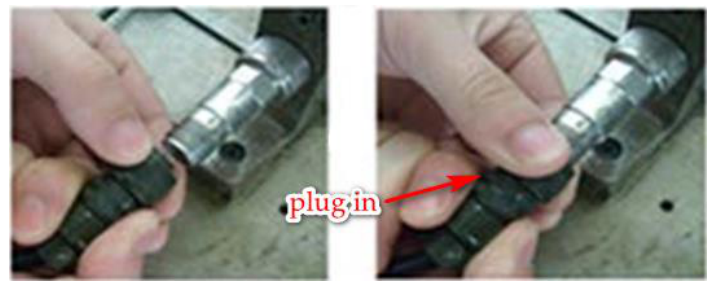
Figure 3. Method to equip the vibrating sensor.